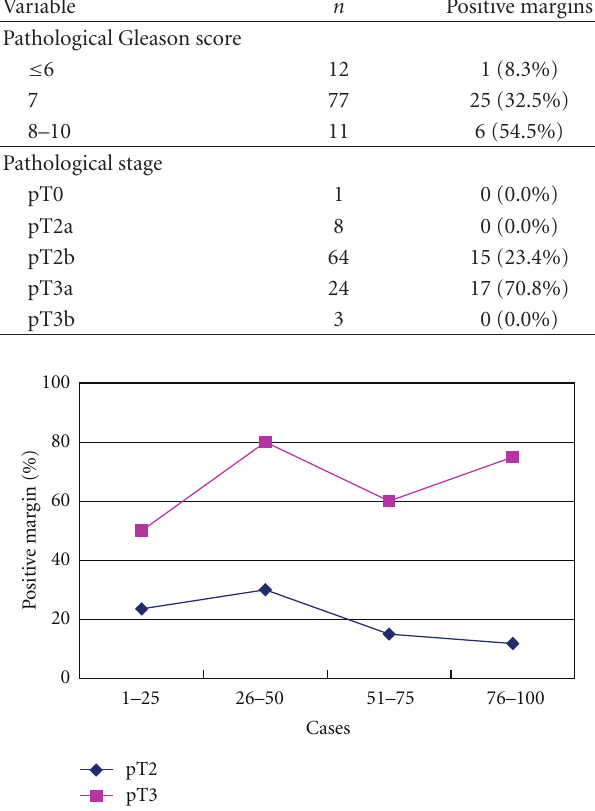
Figure 3: Percentage of positive surgical margins according to pT category and number of cases operated on